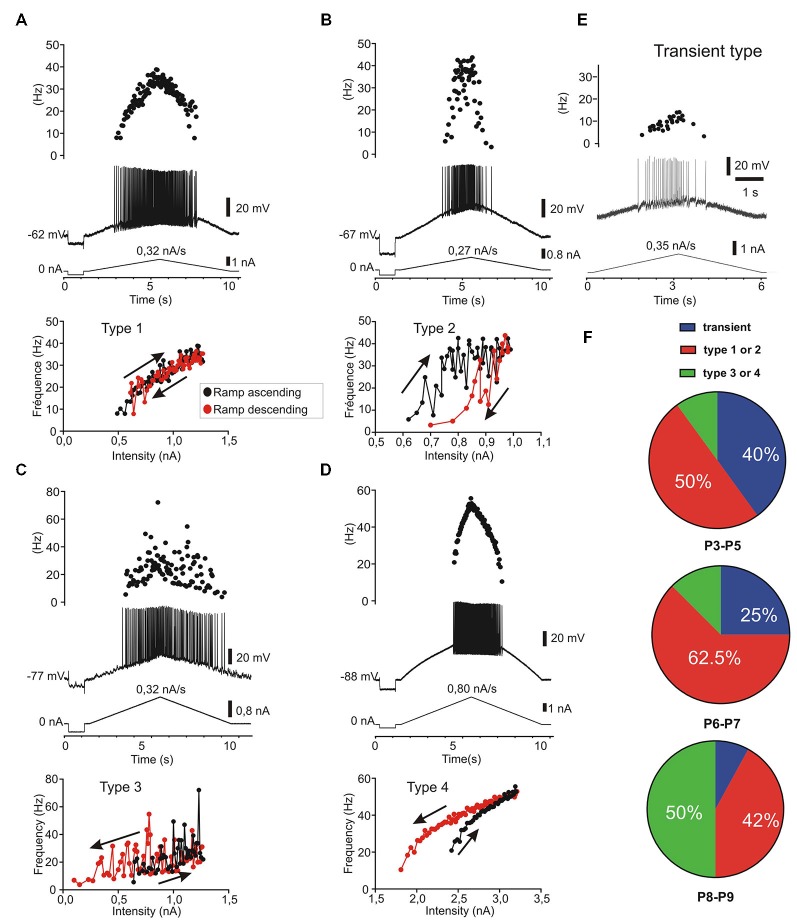
Five patterns of discharge recorded in response to current ramp stimulation in postnatal lumbar motoneurons (n = 38). The four classical types (A–D) as described in adult motoneurons (Bennett et al., 2001) are present and a fifth type called transient, since no discharge firing, or only a few spikes (<5), could be evoked during the descending phase (E). (A) type 1: linear F-I relationship where the firing frequency curves overlapped on the ascending and descending phases. (B) type 2: clockwise hysteresis pattern where the instantaneous frequency is lower in the descending phase for the same current intensity. (C) type 3: Linear F-I relationship with sustained firing in the descending phase. (D) type 4: Counter clockwise hysteresis where the frequency is higher during the descending phase; (E) type 5: transient discharge during the ascending phase with usually no discharge or only a few spikes in the descending phase. In this case which is frequent before P5 (40%), it was not possible to plot an F-I curve during the descending ramp. (F) distribution of the five discharge patterns according to the postnatal ages. Note that types 1 and 2 are the predominant types before P8 (n = 15/26) whereas the types 3 and 4 are most frequent at P8–P9 (n = 6/12) but rare before P8 (n = 3/26).